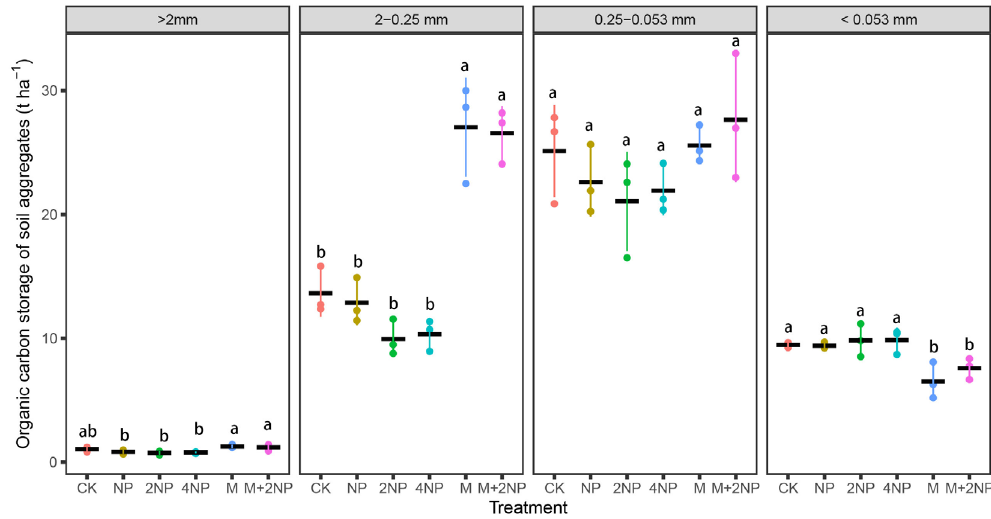
Figure 4. Organic carbon storage of soil aggregates. The black horizontal and colorful vertical lines represent the mean and SD, respectively, and the dots next to them represent the respective measured values. Different lowercase letters show significant differences among fertilization treatments in the same aggregate fractions ( p < 0.05). Values are given as means ± SD (n = 3). Abbreviations: CK = no fertilizer; NP = low − dose chemical fertilizer; 2NP = moderate − dose chemical fertilizer; 4NP = high − dose chemical fertilizer; M = normal − dose organic fertilizer; M+2NP = normal − dose organic fertilizer + moderate − dose chemical